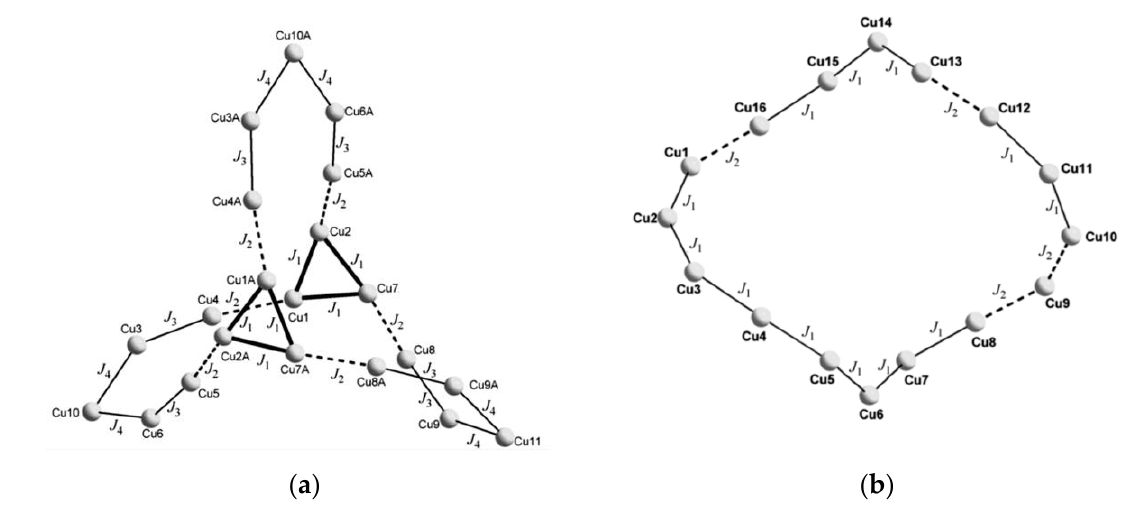
Figure 17. The coupling models of two high-nuclearity copper cage compounds: Cu 21 and Cu 16 . ( a ) Four J exchange pa-